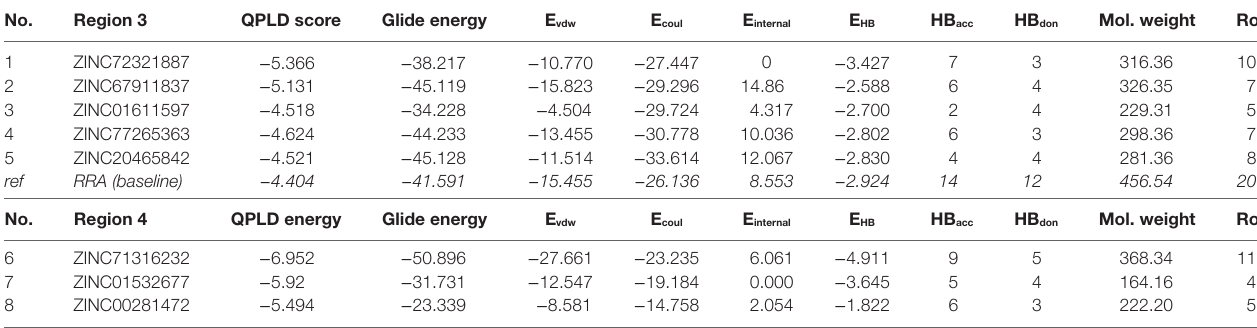
tABLe 1 | Top-ranked compounds targeting regions 3 and 4 of TNF receptor type II from in silico